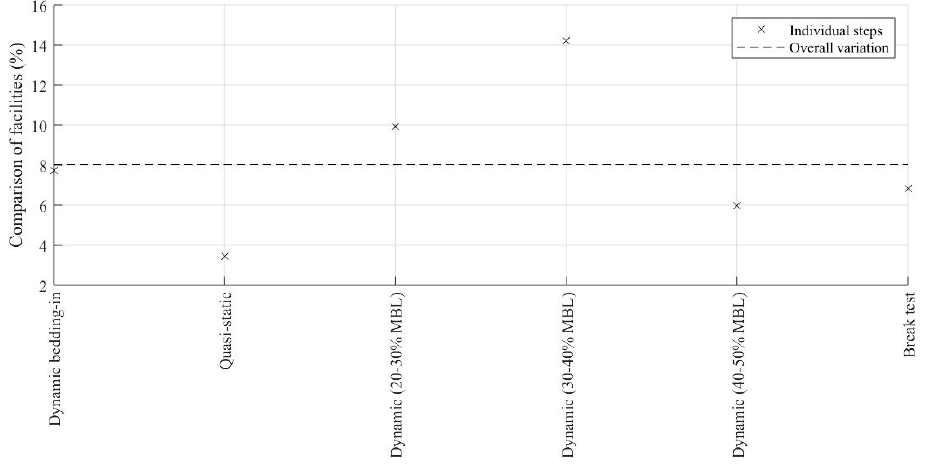
ff erence in mean sti ff ness values at both facilities, DMaC and Figure 14. Percentage difference in mean stiffness values at both facilities, DMaC and IFREMER. Figure 14. Percentage di